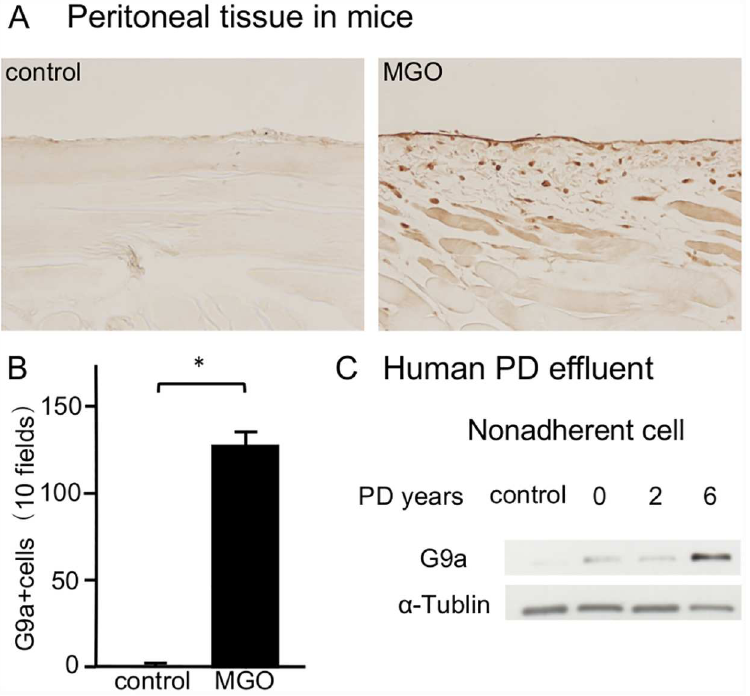
Fig 1. G9a expressionis upregulated in MGO-injected mice and human Peritoneal Dialysis (PD) effluents. (A) Immunohistochemicalstainingshows typical G9a expressionin peritonealtissues of control mice and methylglyoxal (MGO)-injected mice (originalmagnification, × 200). (B) Graph indicatingthe number of G9a-positive cells in mice with or without peritonealinjectionof MGO (n = 5 for both groups). (C) Representative western blot analysisshowingthe levels of G9a expressionin nonadherent cells of humanPD effluents. Data are expressedas the mean ± SE. Statistical analysiswas performed by the Student’s t-test. * P <